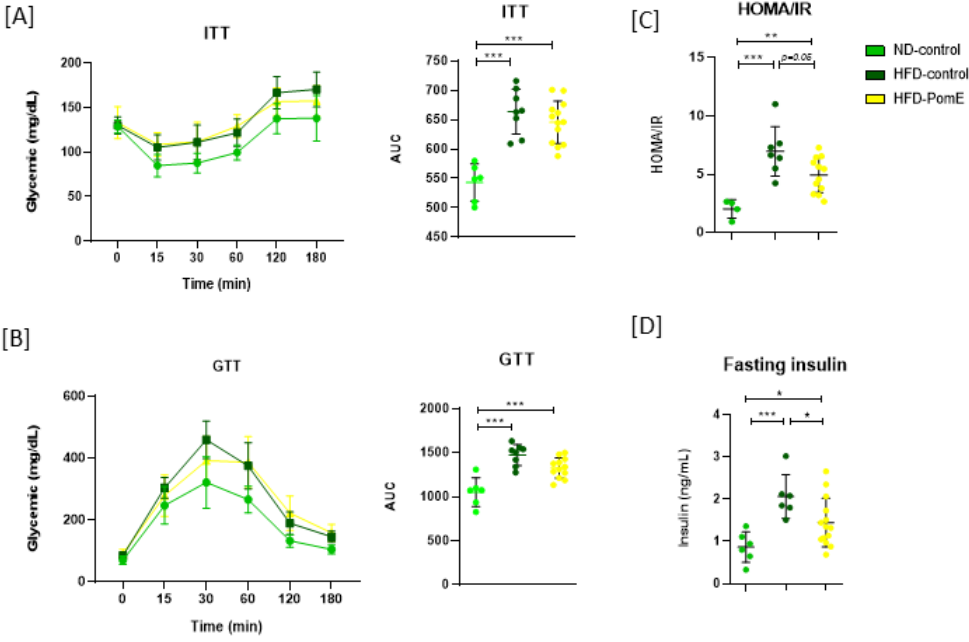
Figure 3. Metabolic phenotyping of glucose and insulin homeostasis in the different groups. Insulin ( A ) and glucose ( B ) tolerance tests were performed at the indicated hours. The area under the curve (AUC) is also represented. ( C ) HOMA/IR values for the different groups. ( D ) Fasting insulin levels for the different groups. Asterisks refer to the comparison with the corresponding control ND group, and between the HFD-PomE and HFD-control groups. Statistically significant values are indicated with asterisks based on their p- value, *, p < 0.05, ** p < 0.01, *** p < 0.001.